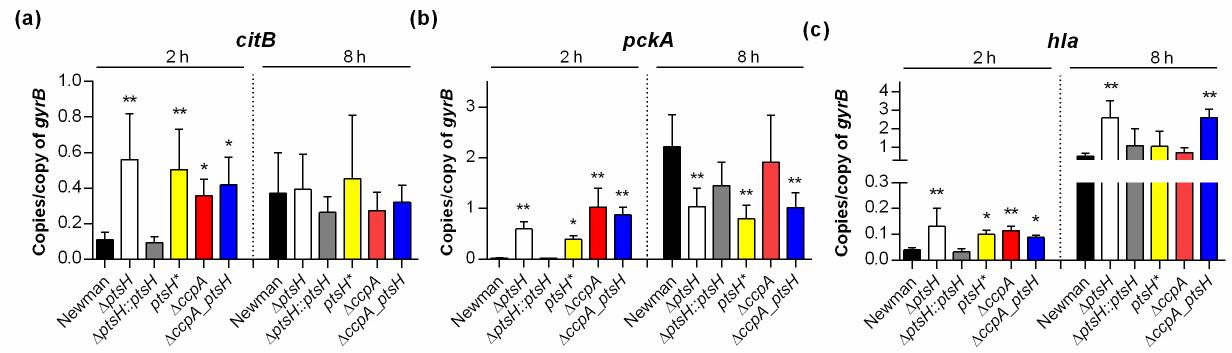
Figure 3. Effect of ptsH and/or ccpA mutations on the transcription of S. aureus . Newman wild type and mutant cells were cultured aerobically in TSB, as outlined in Materials and Methods. Cells were harvested at the time points indicated, total RNAs isolated, and qRT-PCRs performed for citB ( a ), pckA ( b ), and hla ( c ). Transcripts were quantified in reference to the transcription of gyrase B. Data are presented as mean + SD of five biological replicates. *, p < 0.05; **, p < 0.01 (one-way ANOVA and Holm-Sidak’s multiple comparison test; only differences between Newman and mutants are shown).